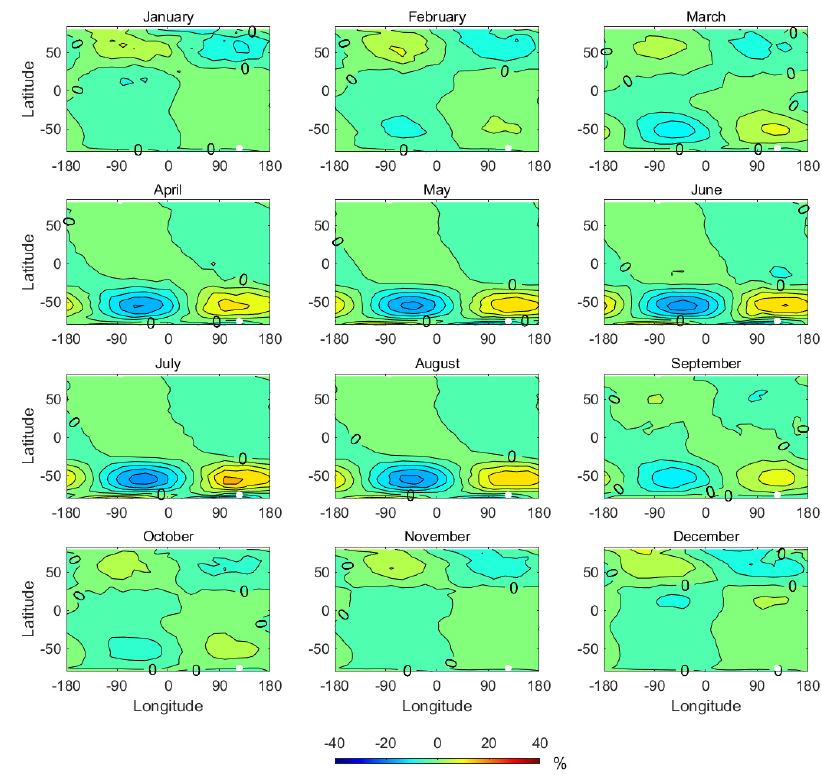
Figure 7. Same as Figure 3, except for the MSIS 2.0 model predictions.